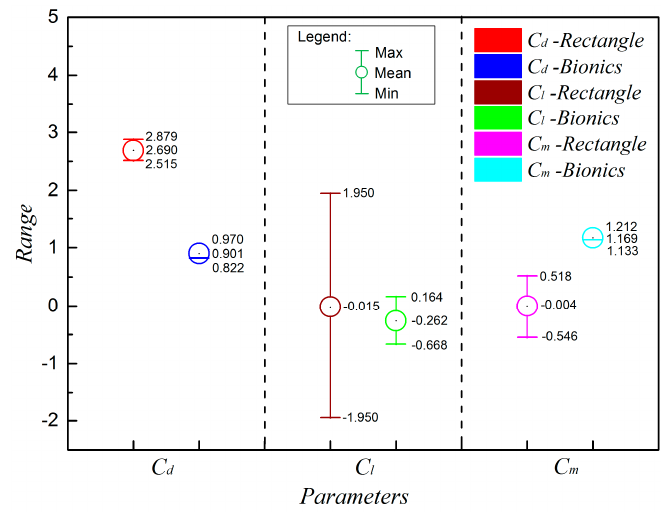
Figure 7. Comparison of the aerodynamic coefficients of the two structures.